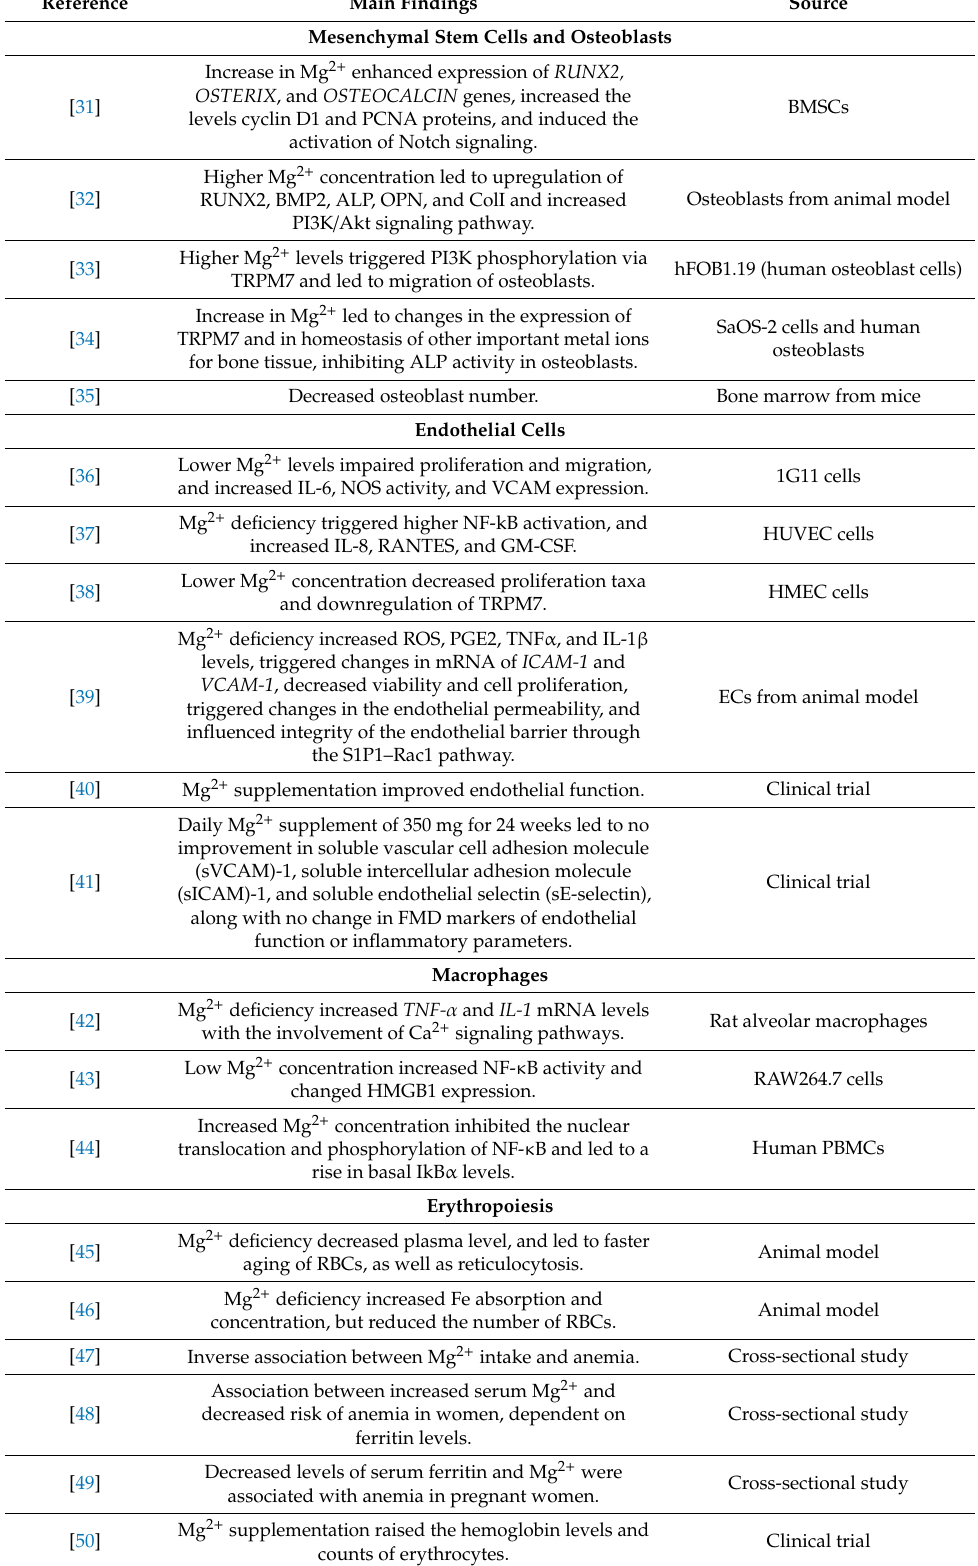
Table 1. Main findings of relationships between Mg 2 + and hematopoietic